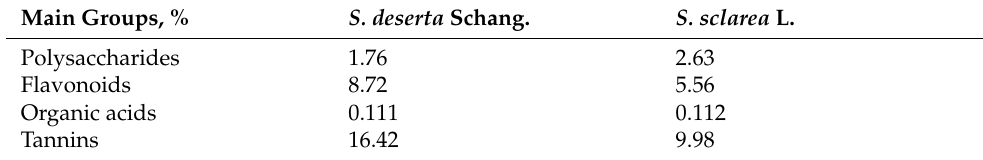
Table 2. The quantitative content of some biologically active constituents in studied plants. Main Groups,